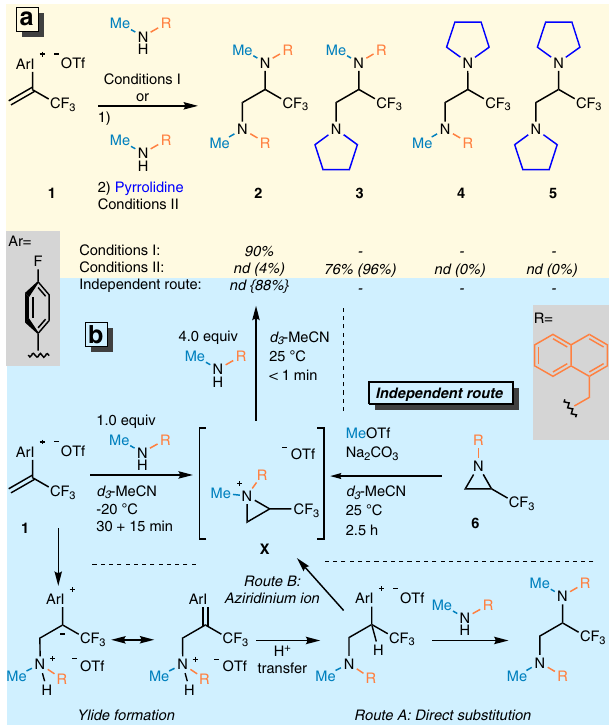
Fig. 2 Experimental mechanistic studies. a Optimized conditions of homodiamination and heterodiamination procedures and mechanistic studies. Conditions I: 1 (0.20 mmol) added in one portion, c = 0.1 M, MeCN, 25 °C, 1 h. Conditions II: (1) 1 (0.15 mmol), MeNHR (0.15 mmol, 1.0 equiv.) added dropwise with syringe pump in 30 min, c = 0.05 M, MeCN, − 20 °C, 15 min; (2) pyrrolidine (0.375 mmol, 2.5 equiv.) added in one portion, 25 °C, 16 h. Yields are isolated yields; numbers given in parentheses () are GC-MS yields of products, relative to 4-F-iodobenzene. b Study of reaction intermediates and resolving their structures by independent route. Number given in {} represents the 19 F-NMR yield of 2